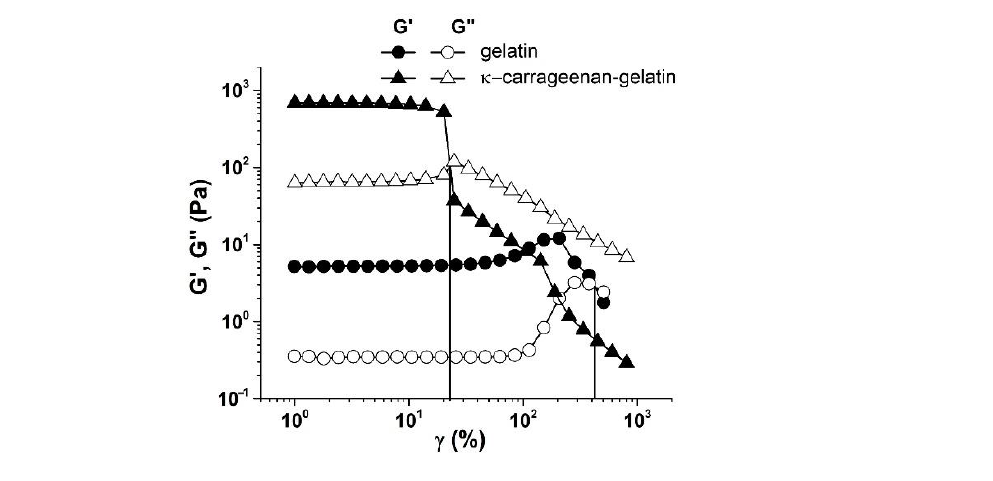
Figure 8. Amplitude dependences of elastic (G’) and loss (G”) moduli for gelatin (gel) („ –) and κ -carrageenan–gelatin (7, 8) at T = 14 ◦ C and ω = 6.28 s − 1 .